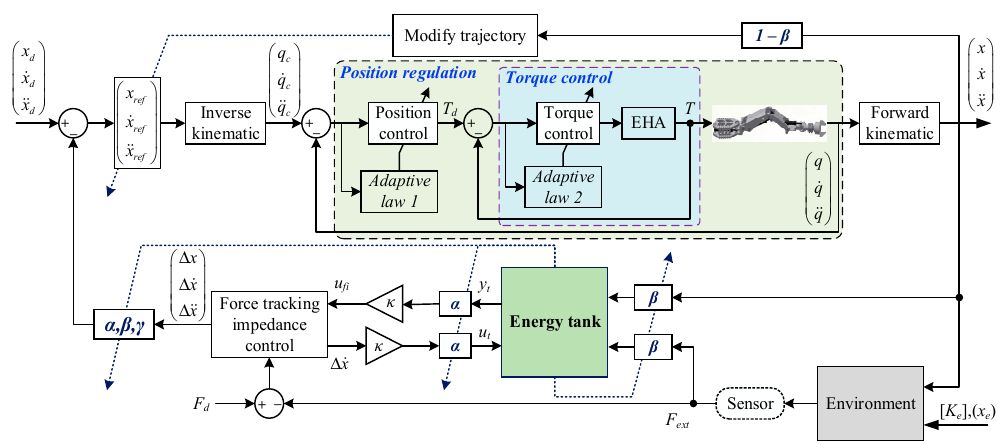
Figure 3. Overall control scheme with energy tank for the n-DOF serial hydraulic manipulator.